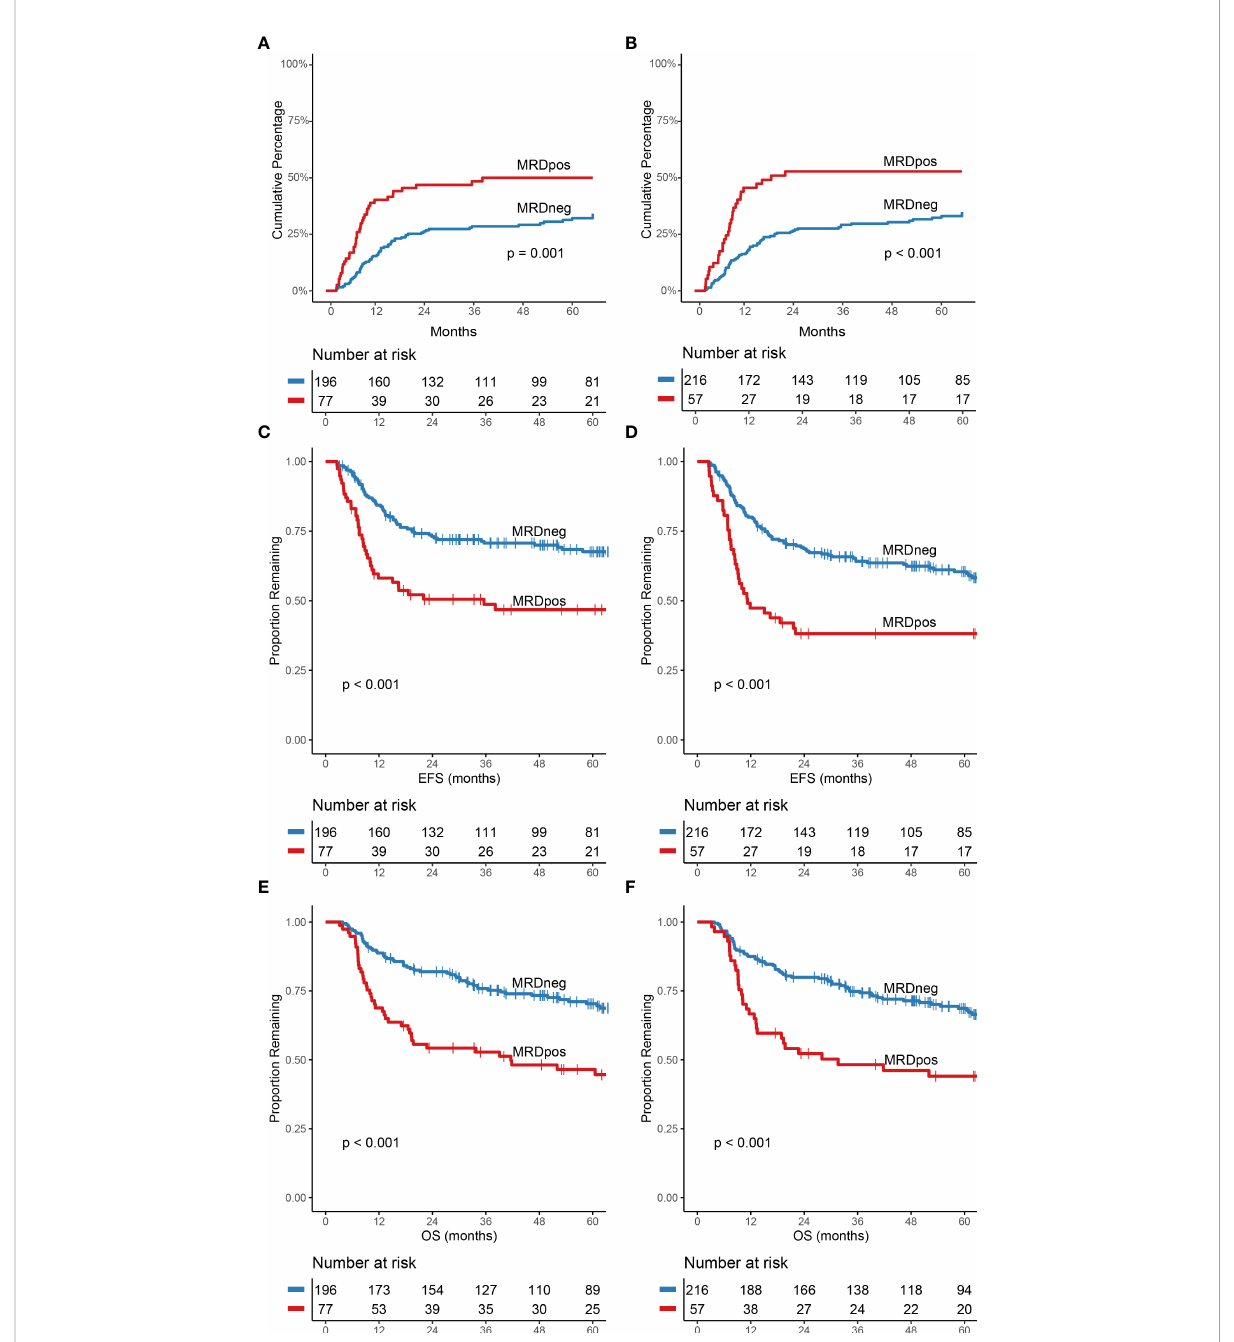
FIGURE 2 Cumulative incidence of relapse, event-free survival and overall survival strati fi ed for MRD-status after cycle 1 and cycle 2. (A) CIR after cycle 1 and (B) CIR after cycle 2. (C) difference in EFS after cycle 1 and (D) after cycle 2. (E) OS difference for MRD status after cycle 1 and (F) after cycle 2. All curves were signi fi cantly different based on MRD-status